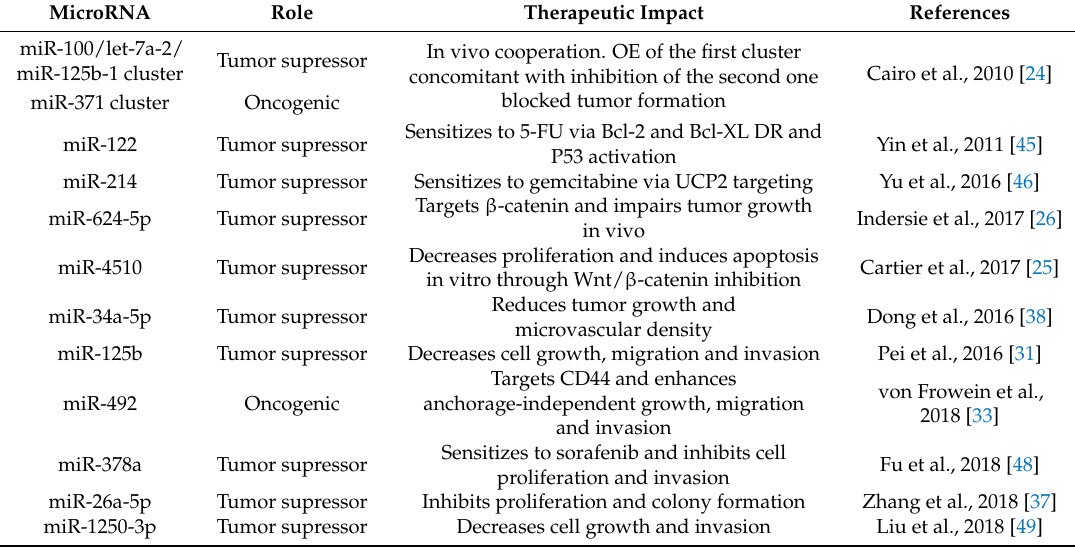
Table 1. MicroRNAs with potential therapeutic value in